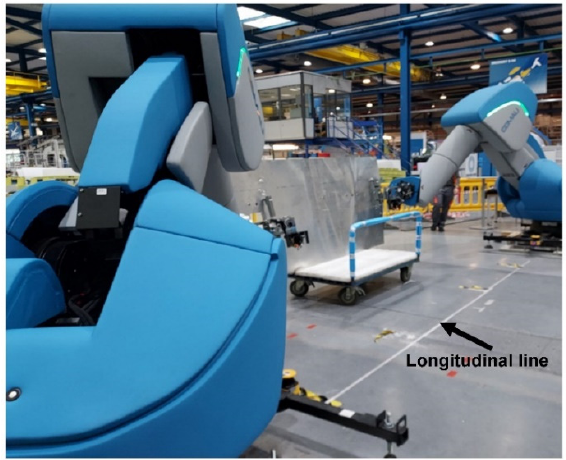
Figure 9. A longitudinal line that connects both robots.